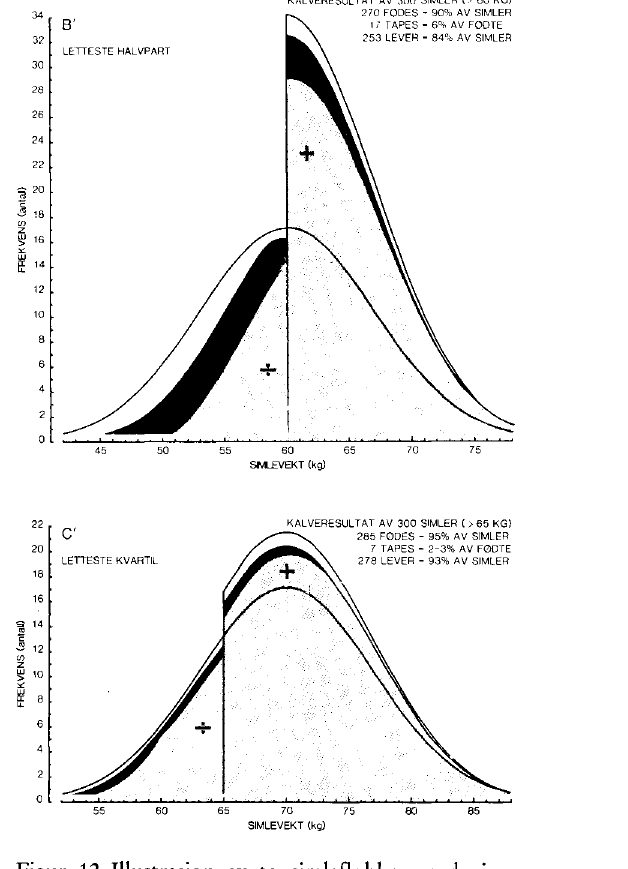
Figur 12. Illustrasjon av to simleflokker med gjenn omsnittsvekt på 60 og 70 kg hvor hen holdsvis letteste halvpart og letteste kvartil er fjernet til fordel for en tilsvarende øk ning innen den tyngste del. Høyre del i begge delfigurene representerer 300 simler som er fordelt i vektklasser på hele kilo. Svart og grå del i «klokkene» angir sam men antall kalver som fødes. Svart del viser kalver som tapes mellom fødsel og